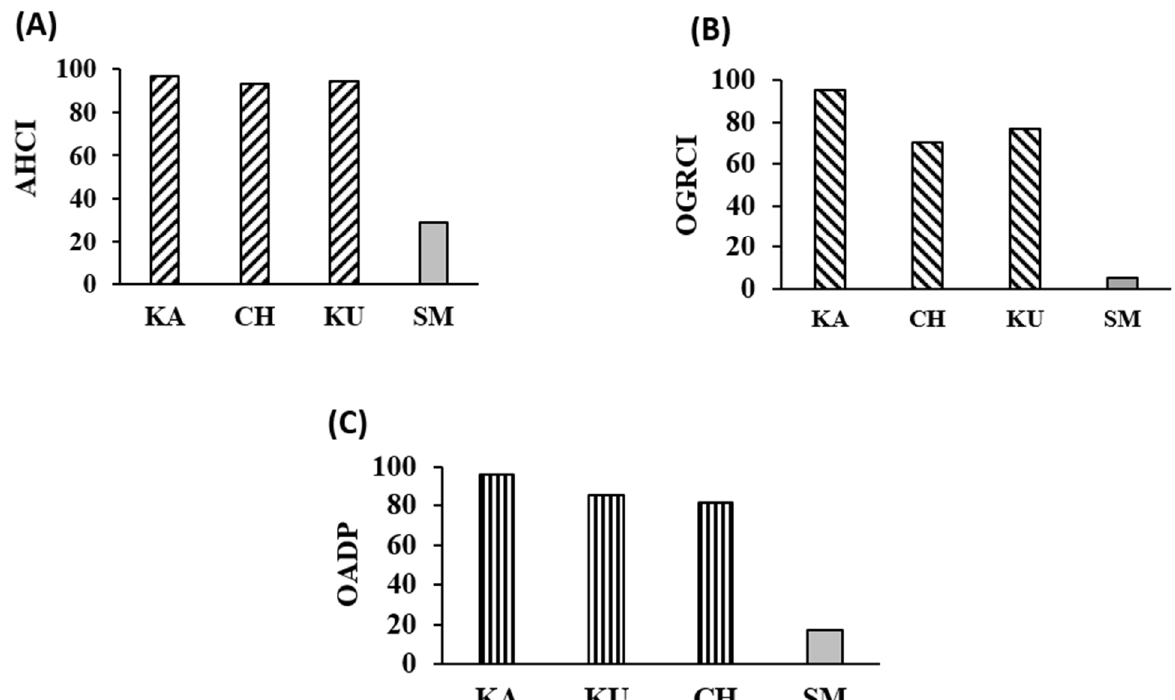
Figure 6. Antidiabetic indices of red rice genotypes. ( A ) Antihyperglycemic composite index (AHCI) ( B ) Oxidation-glycation reduction composite index (OGRCI) ( C ) Overall antidiabetic potential score (OADP). KA—Kattuyanam, CH—Chennangi, KU—Karungkuruvai, SM—Sona Masuri (White rice).